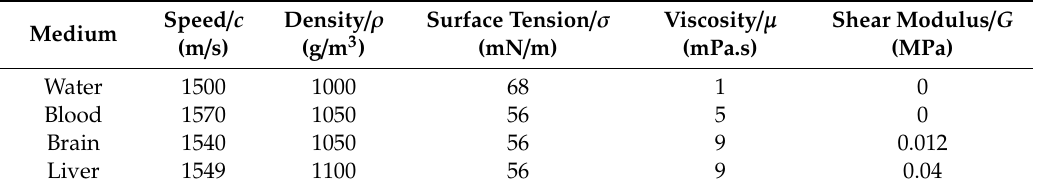
Table 1. Physical parameters of media